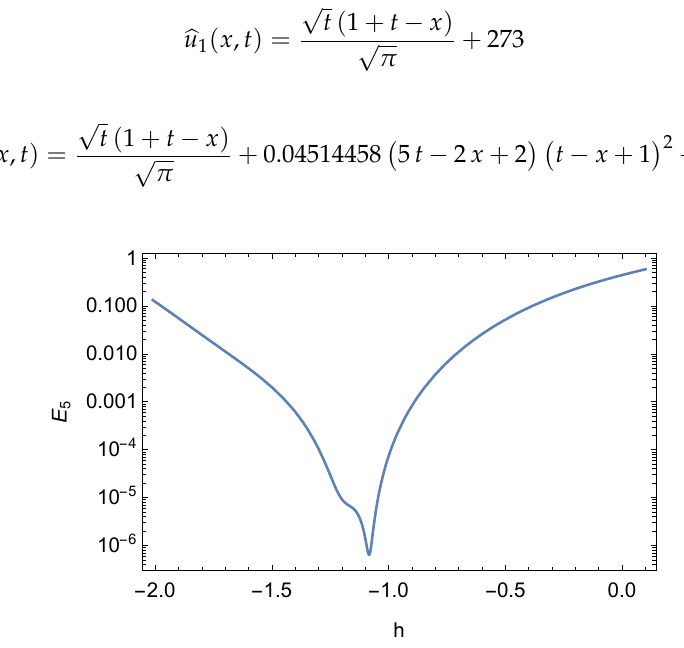
Figure 2. Logarithm of the squared residual E 5